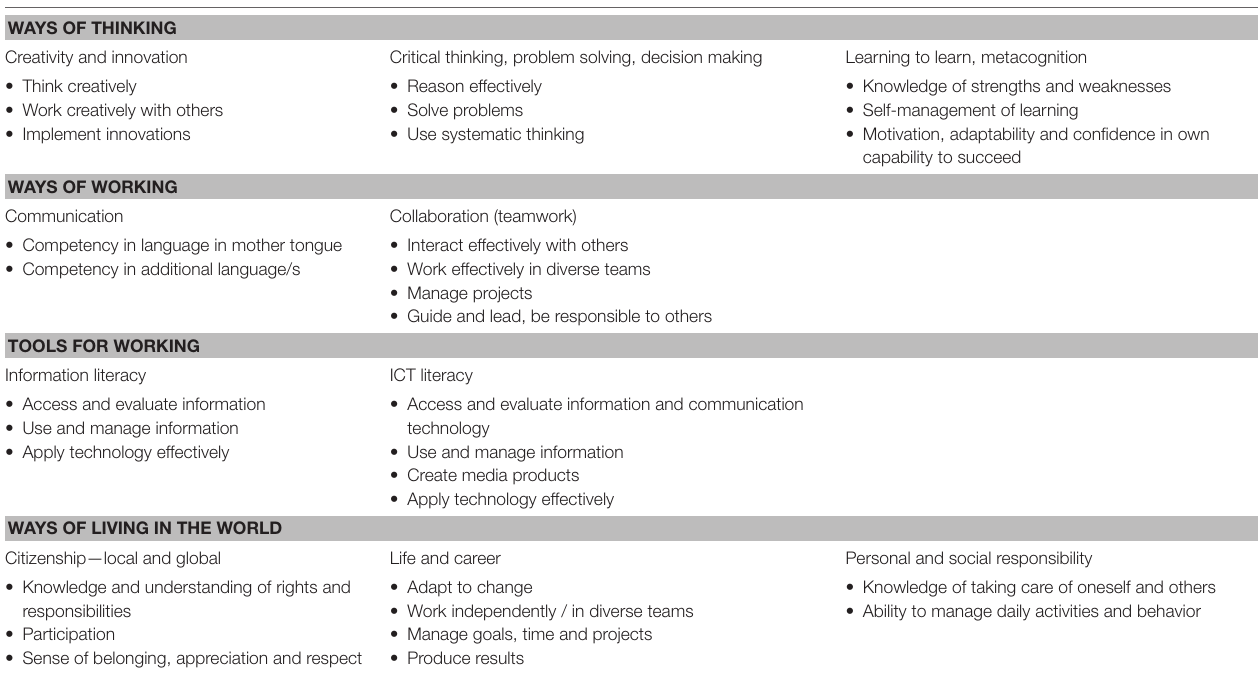
TABLE 1 | Categorization of twenty-first Century Skills in ATC21S framework (Griffin et al., 2012, p. 18–19). WAYS OF